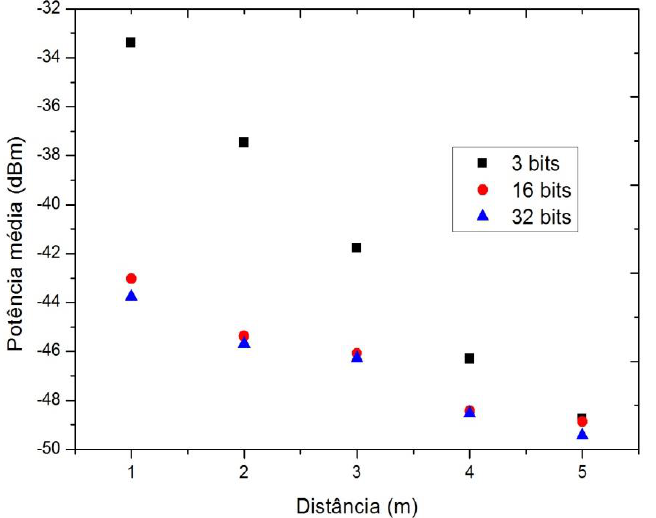
Figura 13: Gráfico da potência com variação da distância e dos dados. Fonte: Autores,